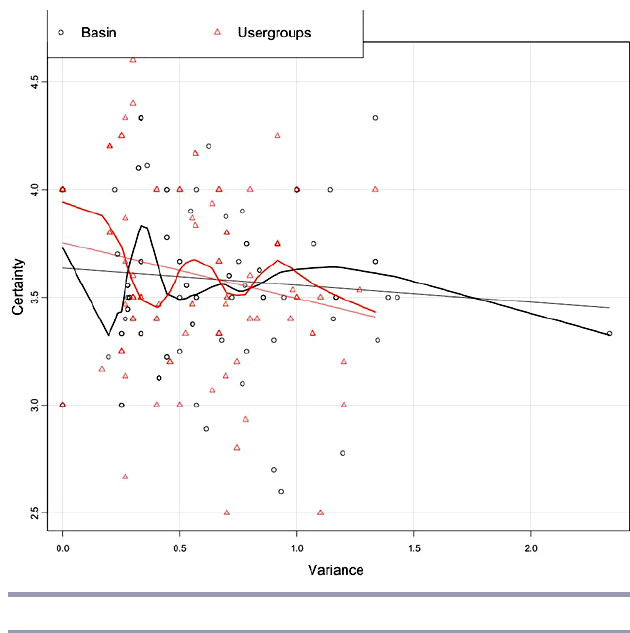
(Fig. 2) for some questions and user groups indicate uncertainty in those areas and opportunities for learning and further probing to determine the sources of uncertainty. Fig. 9 . Relationship between observed variance and user identified level of certainty.